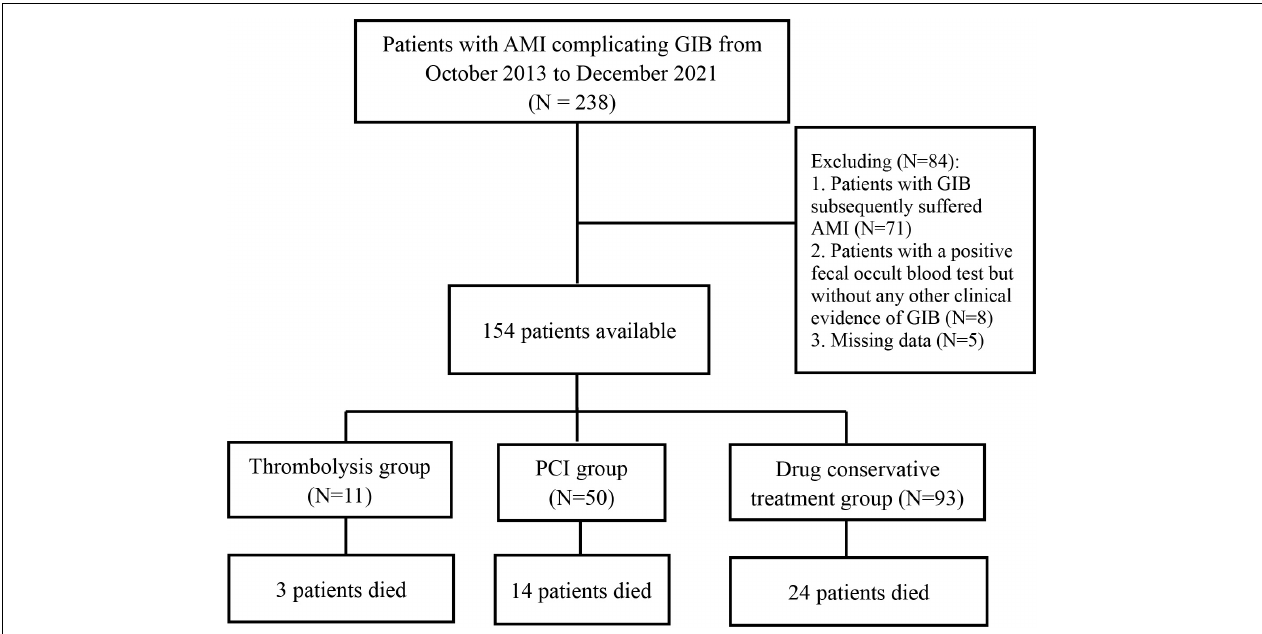
FIGURE 1 | Flow chart for selection of study population. AMI, acute myocardial infarction; GIB, gastrointestinal bleeding; PCI, percutaneous coronary